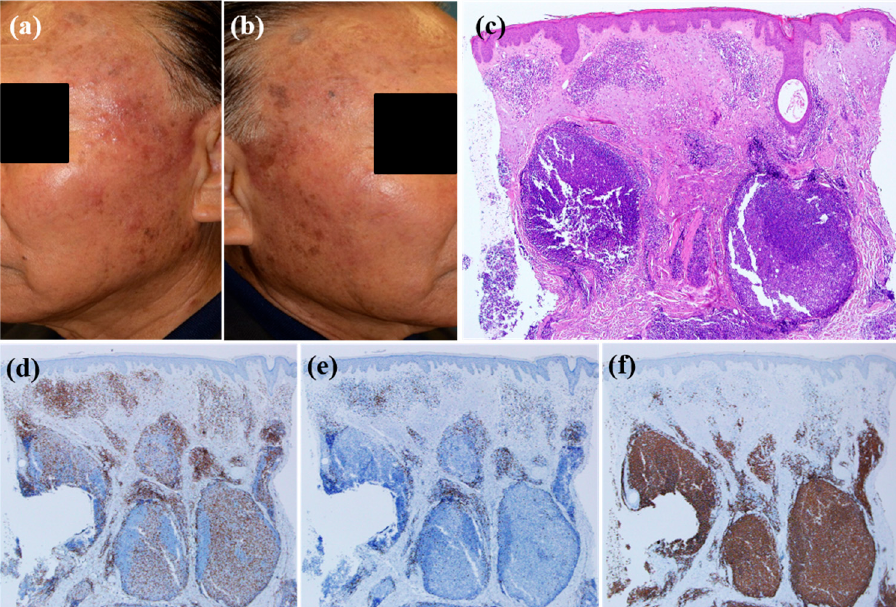
Figure 2. The clinicopathological characteristics of cutaneous lymphoid hyperplasia after hair dye use; ( a – b ) The patient had multiple erythematous nodules on his face after hair dye. ( c ) Skin biopsy reveals nodular and follicular infiltration in the dermis: Hematoxylin-eosin stain; magnification: ×40. Lymphocytes showed weak positivity for CD4 ( d ) and CD8 ( e ), while most lymphocytes stained positive with CD20 ( f ) (×40).